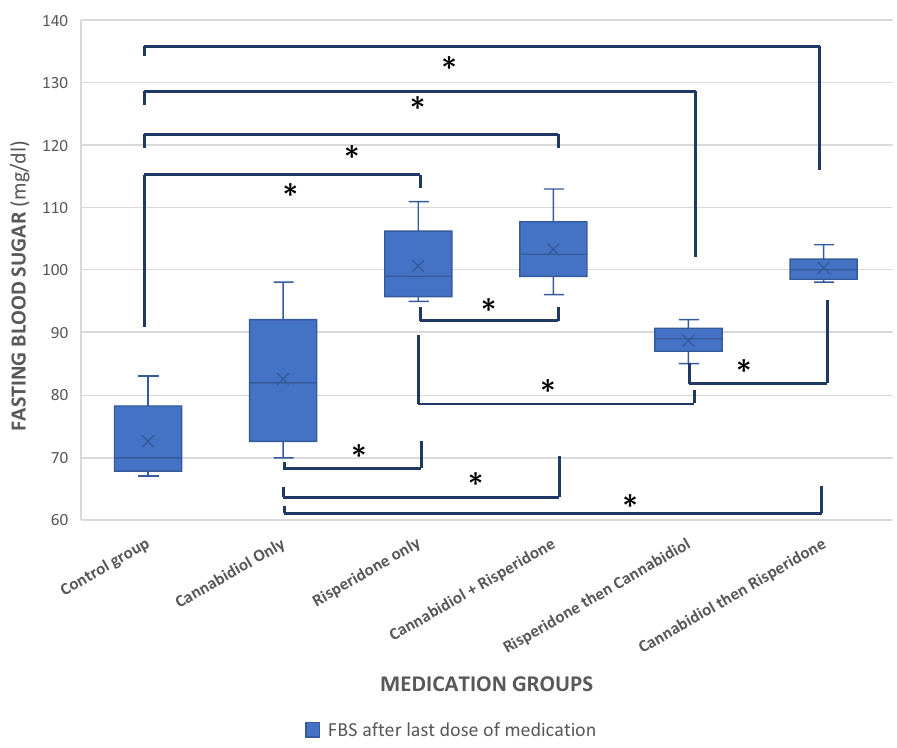
Figure 1. Fasting blood sugar across groups after the last dose of medications. Observations of the post- pharmacological interventions FBS values in each group indicated CBD influenced the FBS values. *Statistically significant difference.